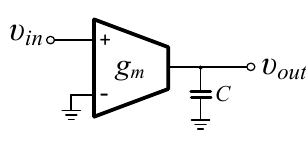
Figure 5. Integer-order integrator topology using OTAs.